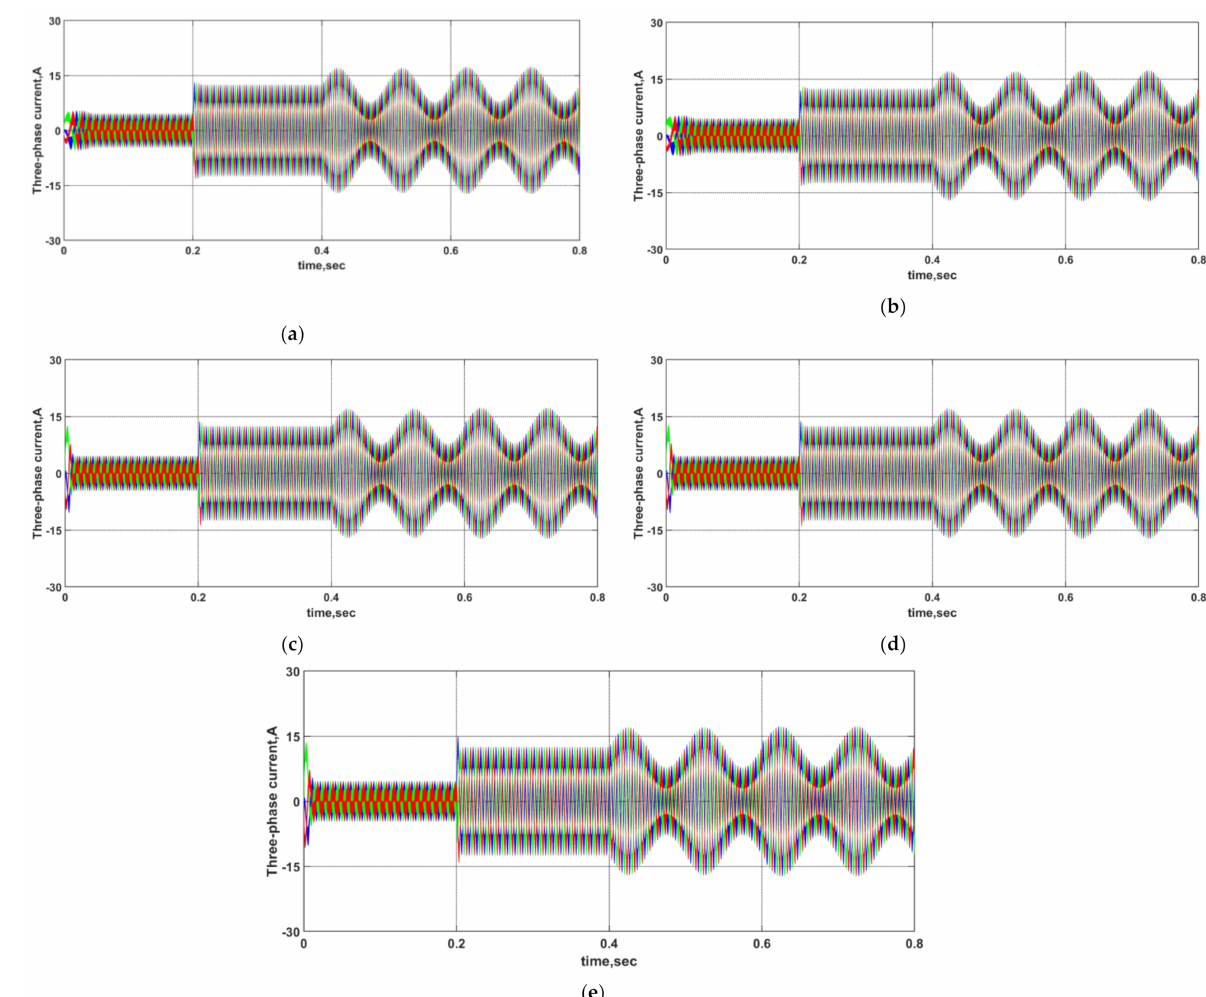
Figure 4. Three-phase currents of the PMSM under the five control methods for compar- ison: ( a ) NTSM-FPRL, ( b ) NFTSM-DPRL, ( c ) NFTSM-SBDPRL, ( d ) NFTSM-SBDPRL-LESO, ( e )